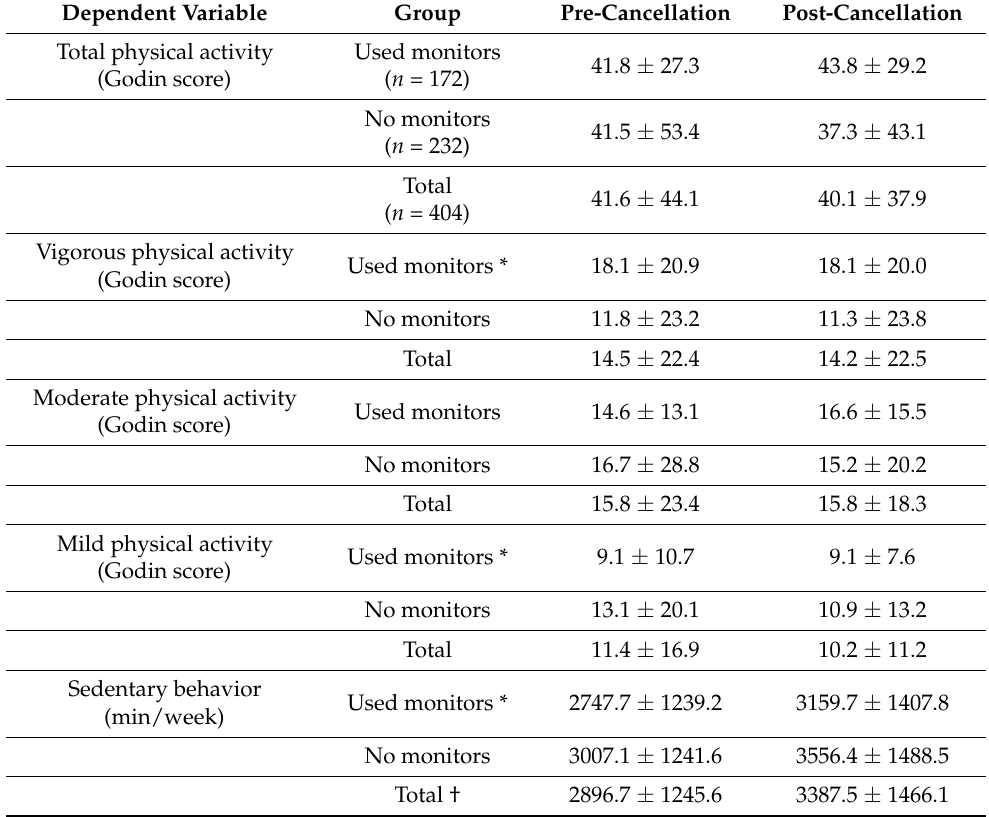
Table 1. Descriptive statistics of dependent variables by